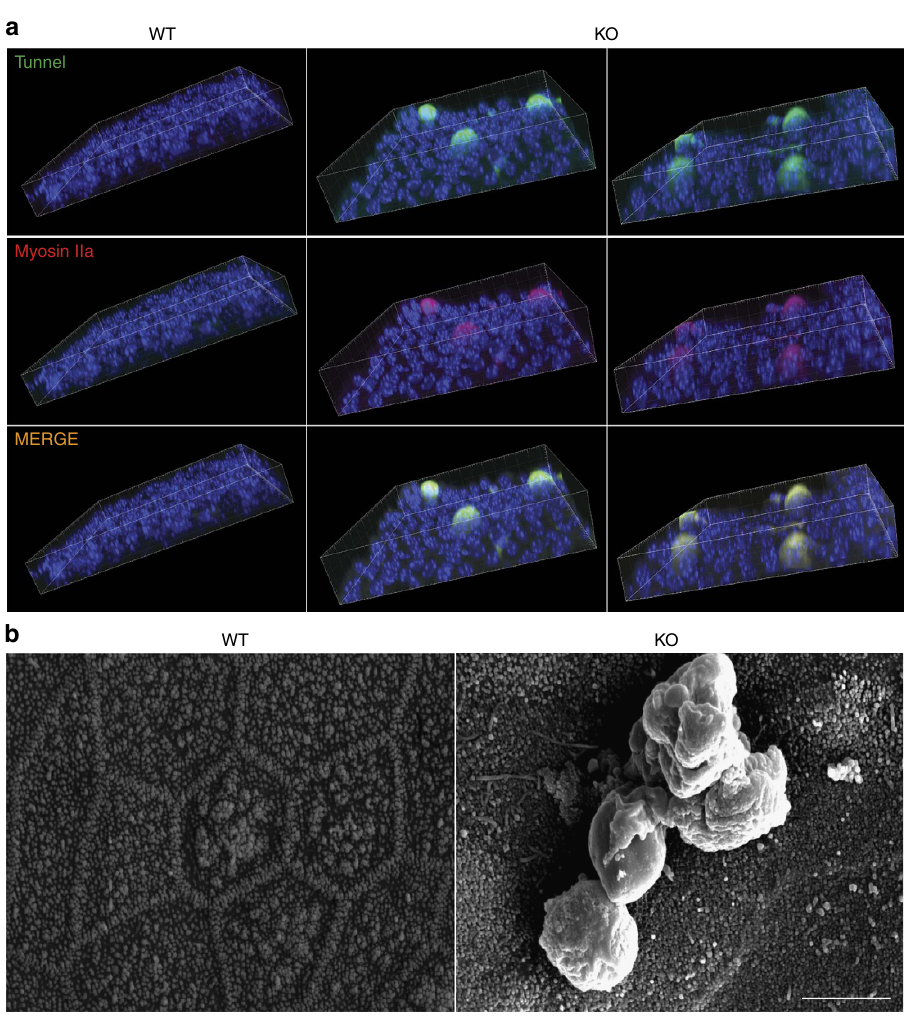
Figure 4 | Alix (cid:2) / (cid:2) epithelia display apoptotic cell extrusion. ( a ) 3D confocal reconstruction of WTand Alix (cid:2) / (cid:2) whole-mount CP showing tunnel þ and Myosin IIa þ cells being extruded from epithelial cell layer of Alix (cid:2) / (cid:2) CP ( n ¼ 3). ( b ) SEM images of cluster of cells extruded from Alix (cid:2) / (cid:2) tracheal epithelial cells. Scale bar, 5 m